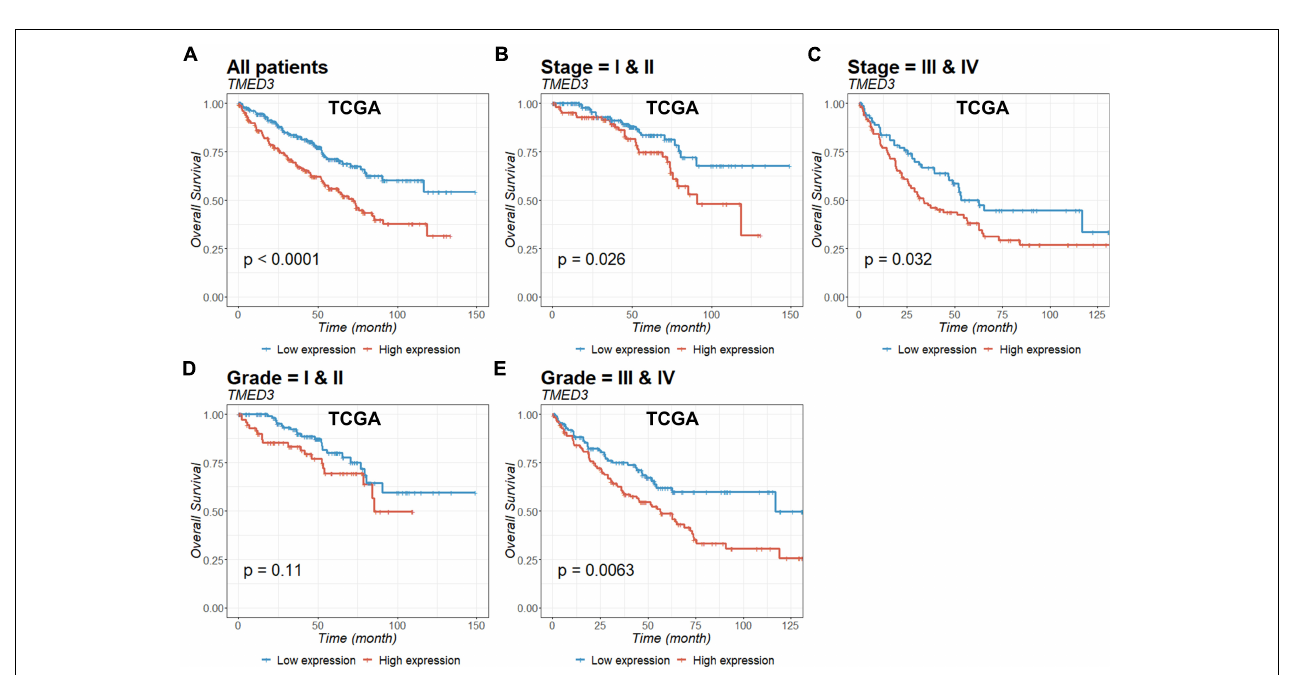
FIGURE 1 | Comparison of TMED3 gene expression between low (Stage I and II) and high stage (Stage III and IV) patients in the TCGA and ICGC ccRCC cohorts as well as the low (Grade I and II) and high grade (Grade III and IV) patients in the TCGA ccRCC cohort. (A,B) TMED3 expression levels in ccRCC patients from the TCGA cohort. (C) TMED3 expression levels in ccRCC cases from the ICGC cohort.